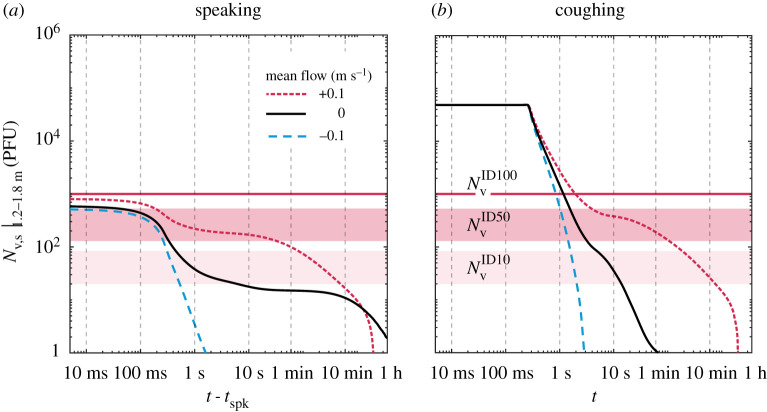
Evolution of the suspended viral dose at face height (between 1.2 and 1.8 m) following (a) 30 s continuous speech and (b) a short cough (i.e. same exhaled liquid mass) for three cases of ambient mean flow: upward (+0.1 m s−1), zero, downward (−0.1 m s−1)—low-protein sputum, (RH = 40%, nv,0=109 copies mll−l). (Online version in colour.)